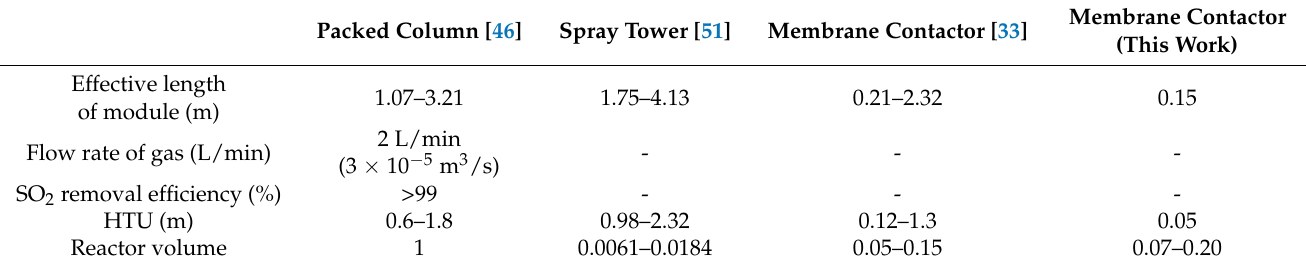
Membrane Contactor (This Work)